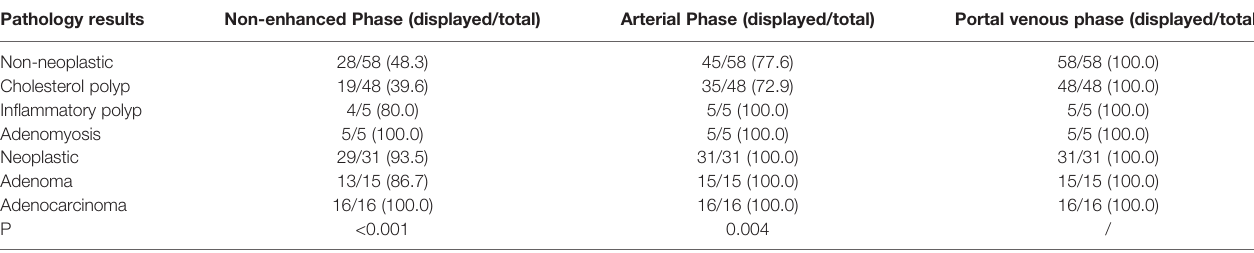
TABLE 2 | Detection rate of CT in the non-enhanced phase and enhanced phase. Pathology results